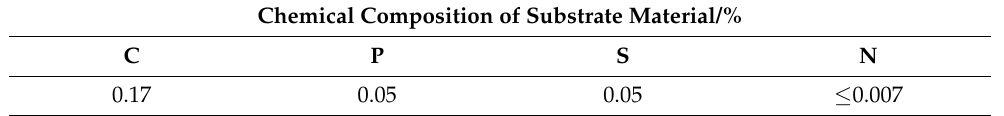
Table 2. Chemical composition of substrate material [29].